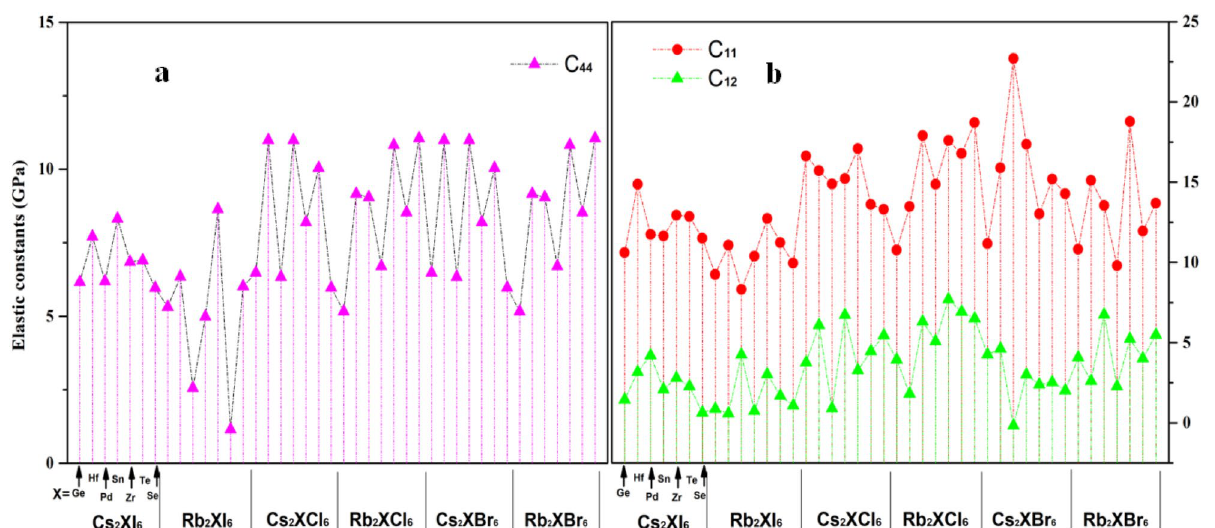
Figure 15. The intuitive graphics of the three components of elastic modulus are ( a ) C 44, ( b ) C 11 , C 12 respectively, and they can show the elastic modulus along different axes of the